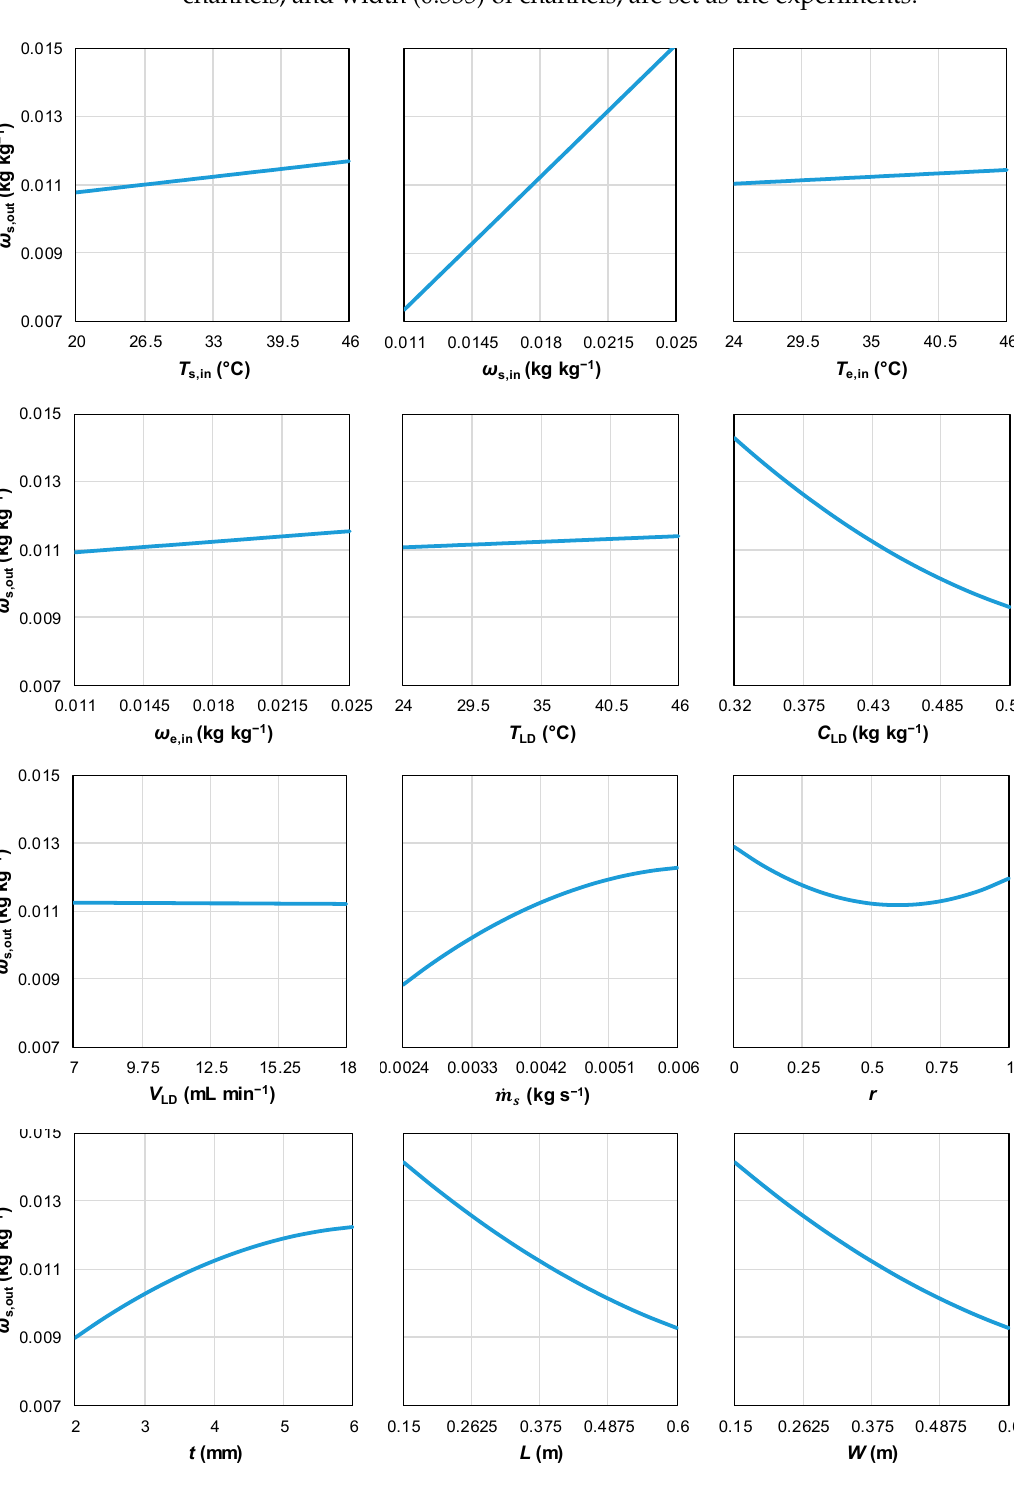
Figure 7. Main effect plots: the supply air outlet humidity ratio at the levels of the 12 input factors. From the third group, increasing the supply air mass flow rate leads to higher supply air outlet humidity ratio; that is, less dehumidification. Increasing the ratio of the exhaust to supply air mass flow rate improves the dehumidification; however, it reaches an opti- mum level between 50% and 75%, beyond which, increasing the mass flow rate ratio has a negative effect on the dehumidification process. This is in agreement with experimental